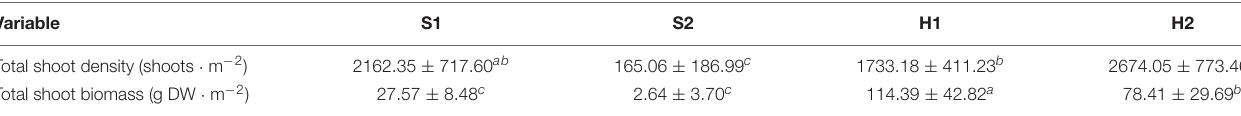
Different letters indicate significant differences at p < 0.05. Values are mean ± SD (N = 7 cores per site).